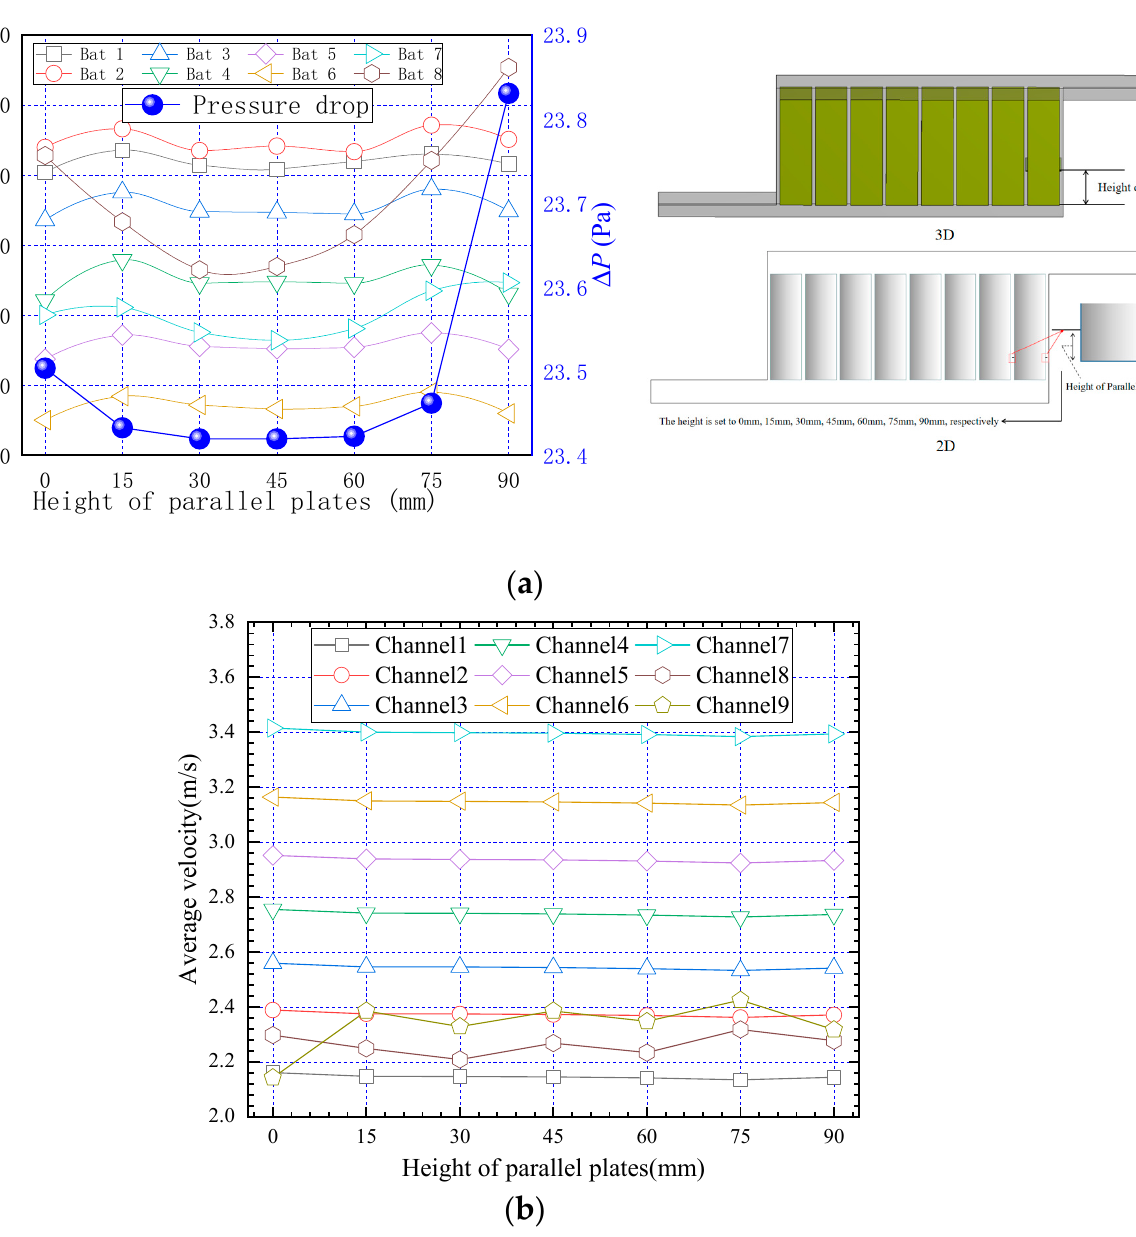
Figure 12. Effect of parallel plates installation height on cooling performance of the model; ( a ) cooling performance of the